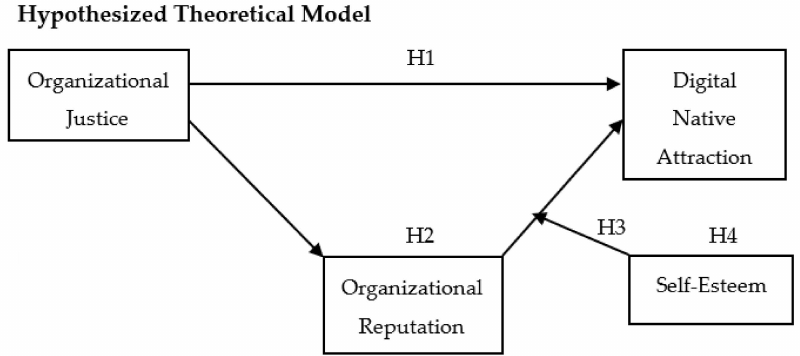
Figure 1. Model of Organizational Justice Inference and Digital Native Attraction